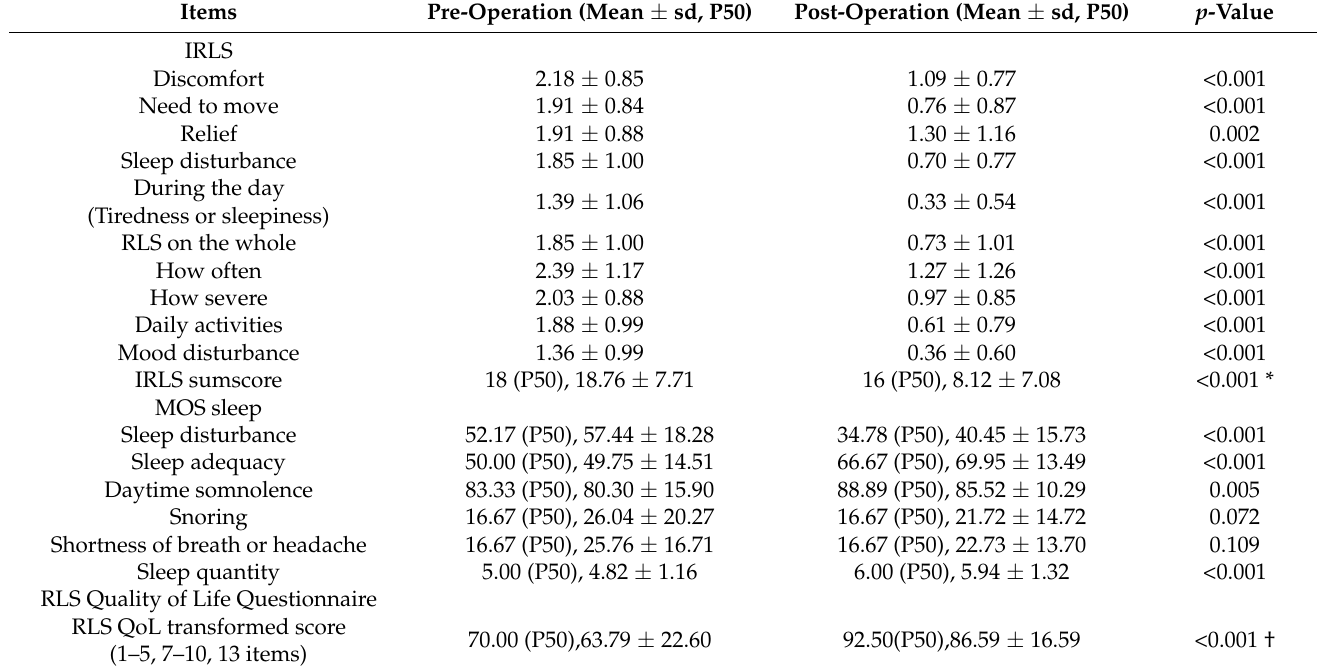
Table 2. The IRLS, MOS sleep and RLS QoL scores pre- and 1 year